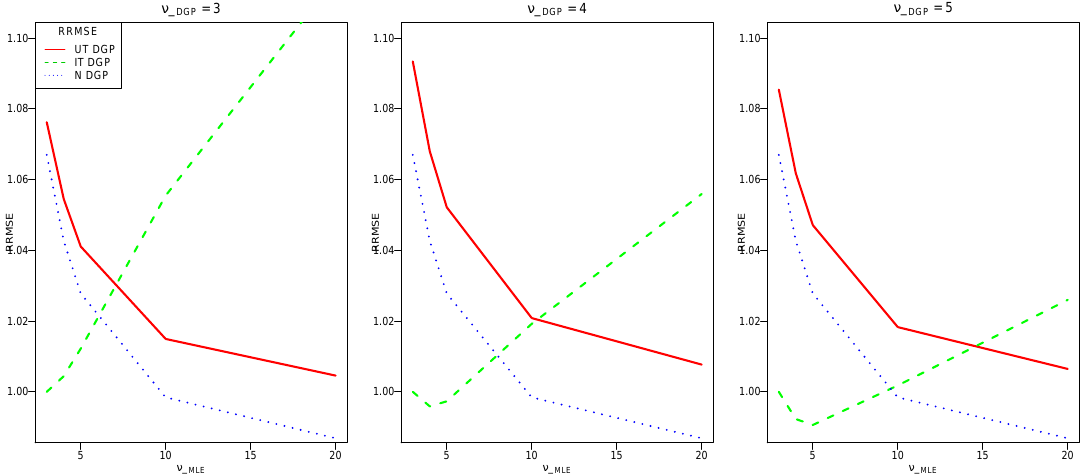
Figure 1. The RRMSE of the IT estimator of ˆ β 12 for the UT DGP in solid line, for the IT DGP in dashed line, and for the Gaussian DGP in dotted line with ν DGP = 3 (respectively, ν DGP = 4, ν DGP = 5) on the left (respectively, middle, right)